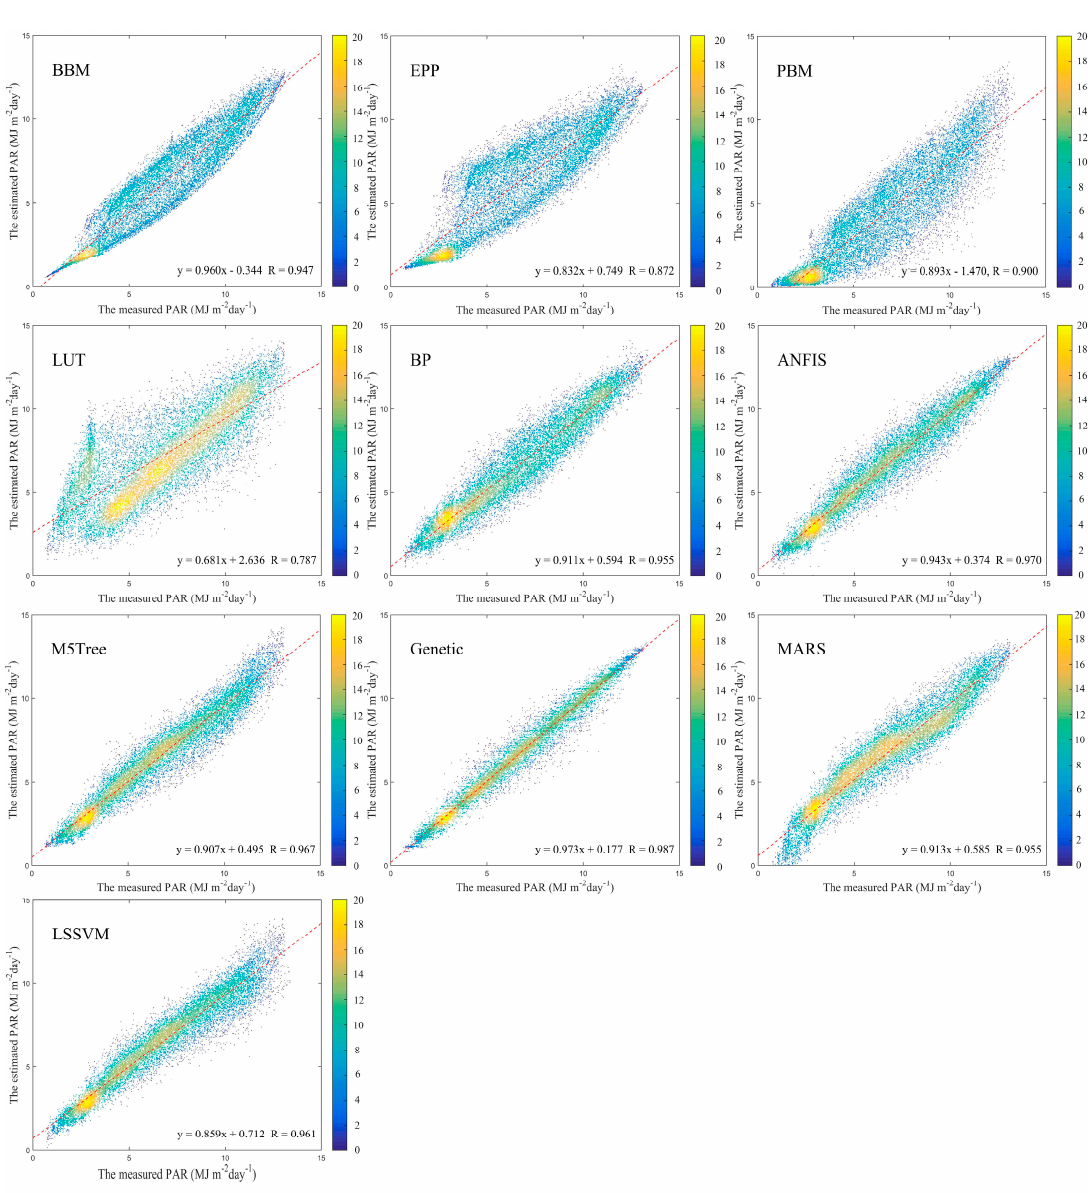
Figure 5. Validation of the PAR models at the CERN stations.